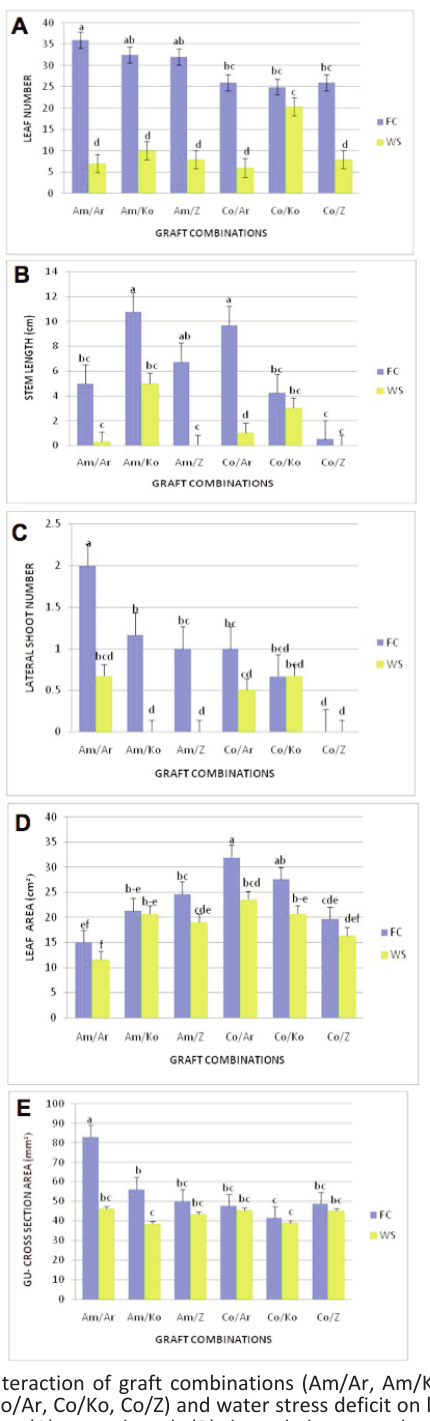
Fig. 2 - Interaction of graft combinations (Am/Ar, Am/Ko, Am/Z, Co/Ar, Co/Ko, Co/Z) and water stress deficit on leaf num- ber (A), stem length (B), lateral shoot number (C), leaf area (D) and gu-cross section area (E). Am (Amygdalifolia), Ar (Arbequina), Ko (Koroneiki), Co (Conservallia) and Z (Zard). Vertical bars indicate SE. Each value represents the mean ± SE of 3 replicates. Means with the same letters are not significantly different (P>0.05) using Duncan Multiple Range Test.